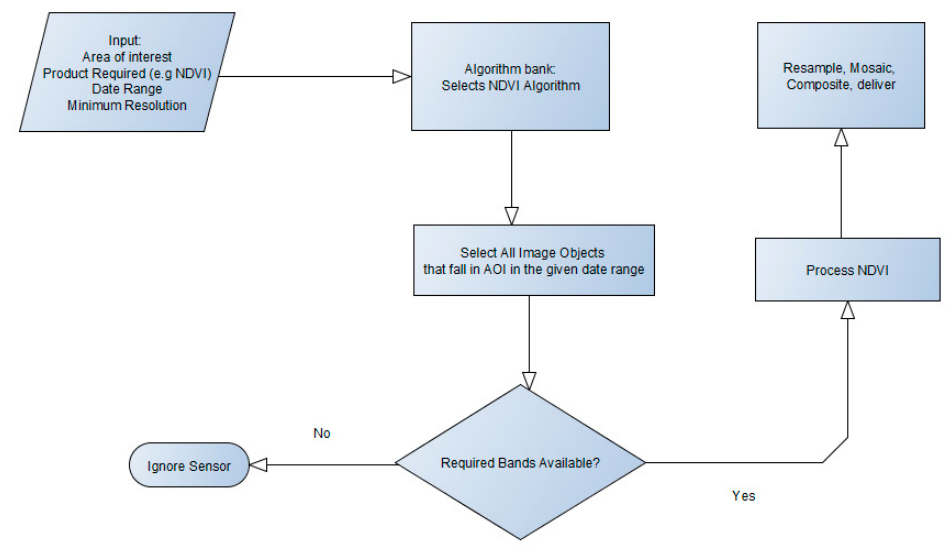
Figure 5. Simplified example of a sensor-independent algorithm that uses an area of interest and bands available at a defined minimum resolution.